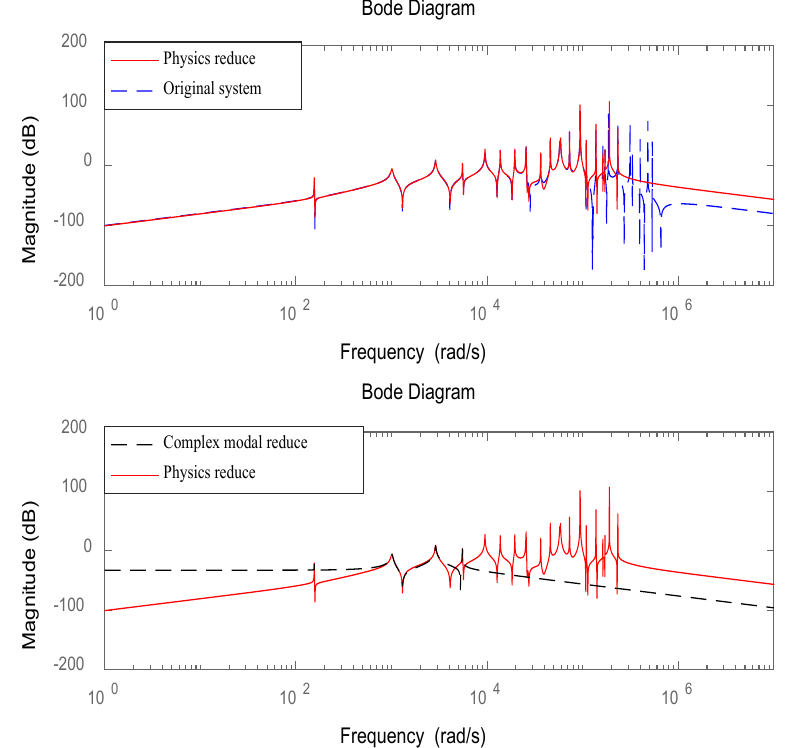
Figure 5. Bode plot for reduced system model of structure 2.